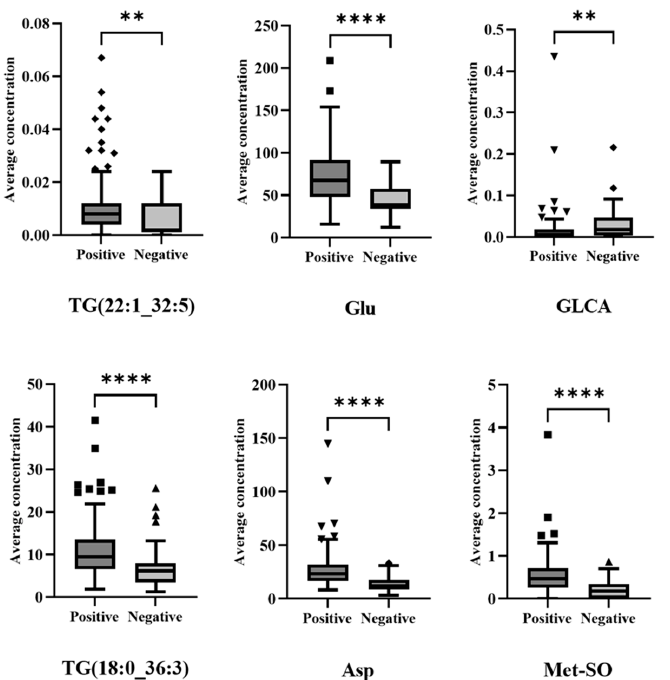
Figure 4. Box plots (outliers shown as symbols outside of whiskers) to compare positive and negative patients for the 6 metabolites shown to differentiate across both waves (**— p < 0.01, ****— p < 0.001).